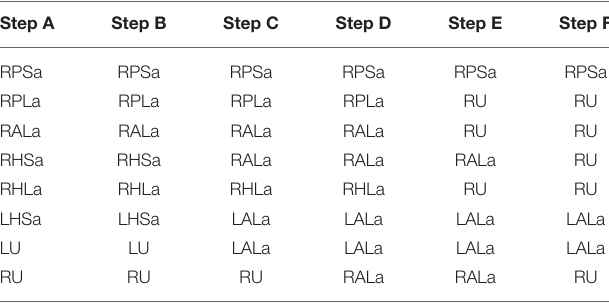
TABLE 1 | Changes of otolith position at different positions during the right Epley